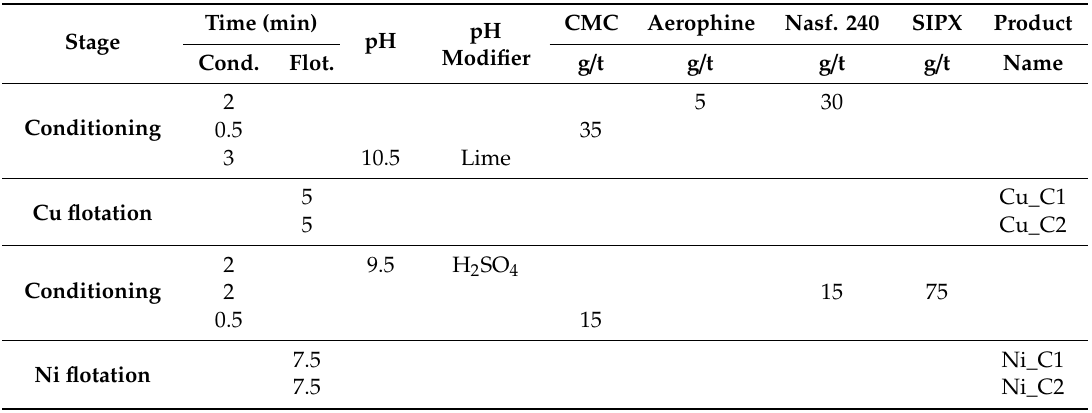
Table 4. Flotation procedure.